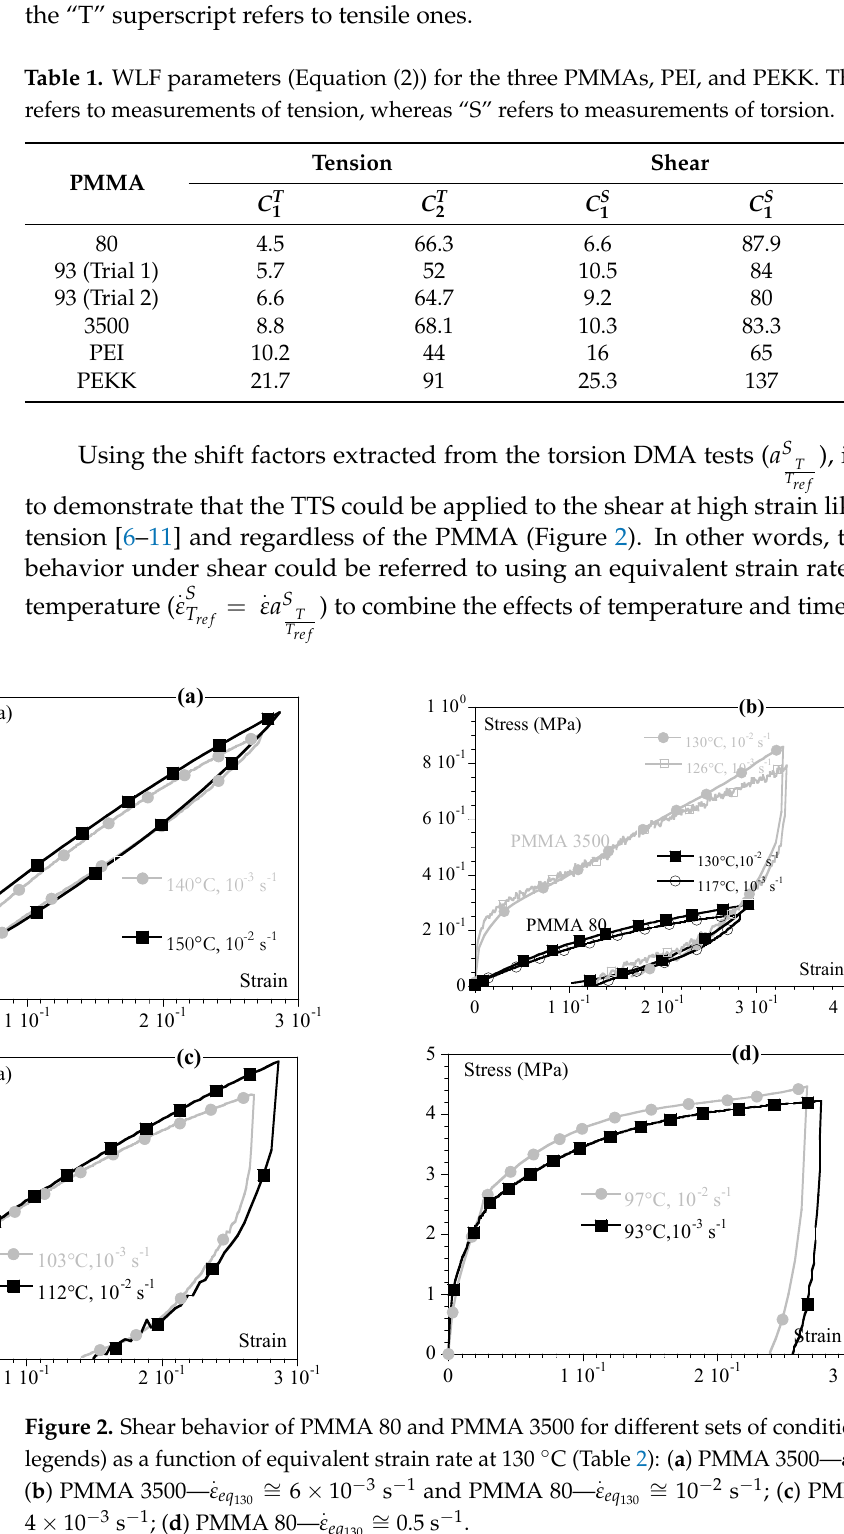
. ≅ 10 (cid:2879)(cid:2872) 𝑠 (cid:2879)(cid:2869) ; ∼ = 10 − 4 s − 1 ; ε eq (cid:3117)(cid:3119)(cid:3116) 130 ≅ 10 (cid:2879)(cid:2870) 𝑠 (cid:2879)(cid:2869) ; ( c ) PMMA 80— 𝜀(cid:4662) (cid:3032)(cid:3044) ≅ ∼ = 10 − 2 s − 1 ; ( c ) PMMA 80— . ε ∼ = (cid:3117)(cid:3119)(cid:3116) (cid:3117)(cid:3119)(cid:3116) eq 130 eq 130